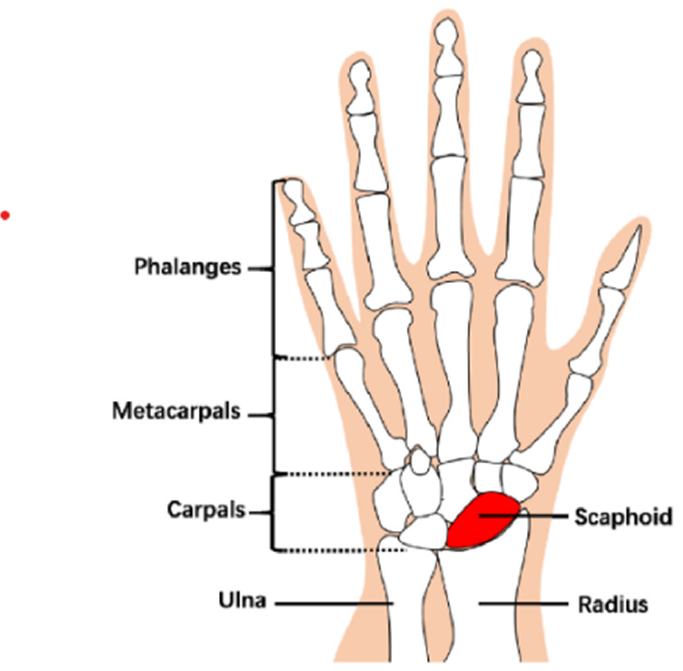
Figure 1. The anatomical structures of the wrist bone, in which the region with red is the scaphoid. A scaphoid fracture is usually diagnosed by an X-ray of the wrist [2]. However, a break in the bone that cannot yet be seen on X-ray is called an “occult” fracture. The occult fractures may be difficult to detect by eye observations because their occurrence probability has been estimated at 7–21% reported in a recent prospective study [3]. If pain persists, a